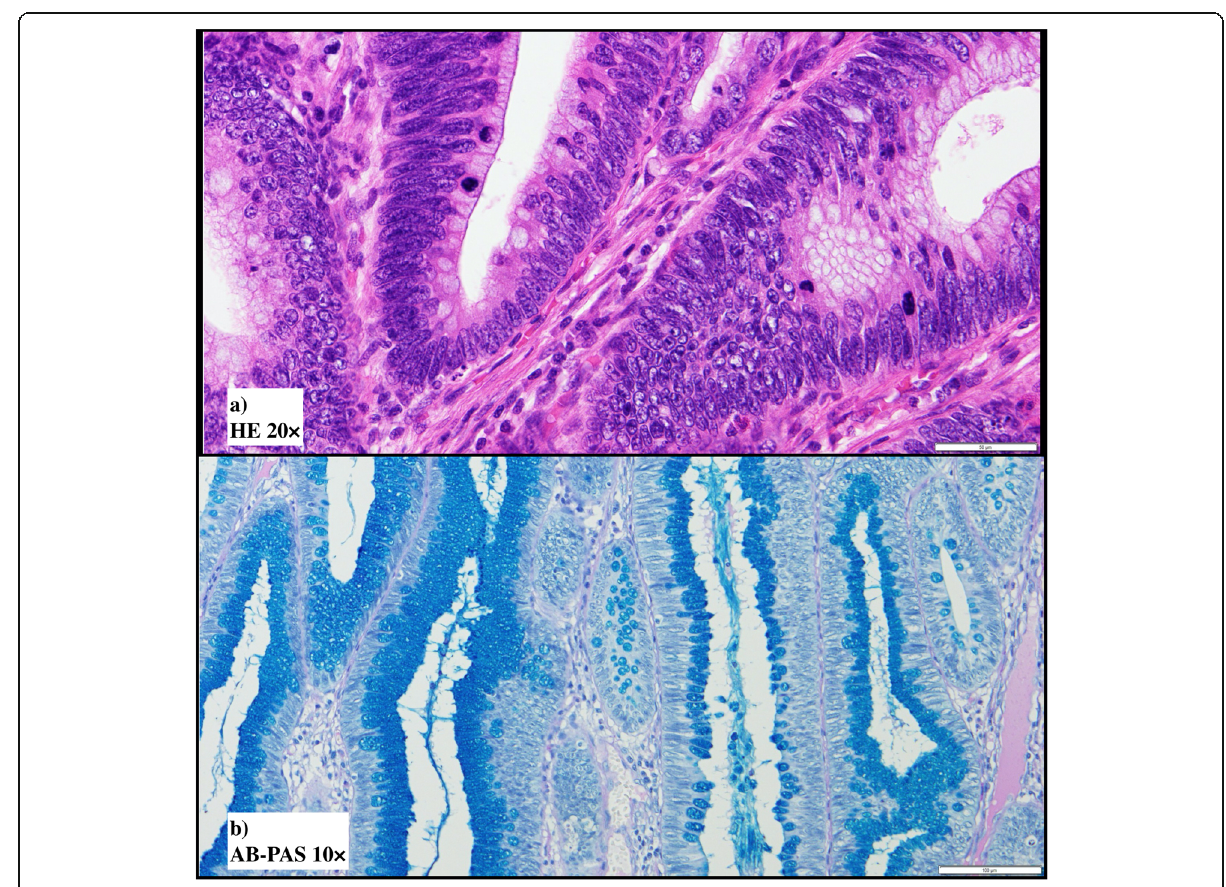
Fig. 6 Microscopic findings of the dysplasia indicated by blue line in Fig. 3b ( a HE ×20, b alcian blue — PAS ×10). a , b Low- and high-grade dysplasia in this lesion had alcian blue-positive mucin in the supra-nuclear